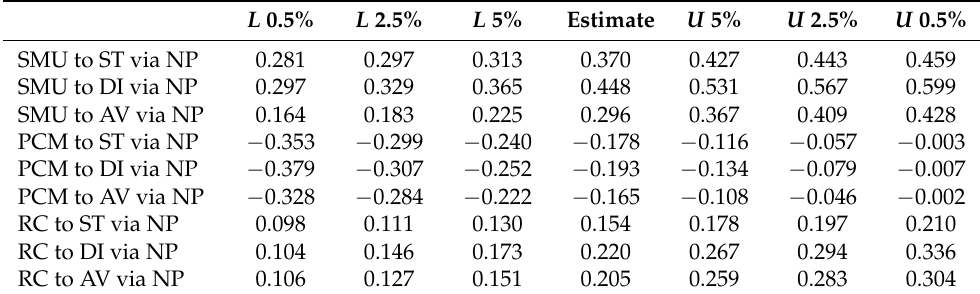
Table 4. Confidence intervals of standardized mediation